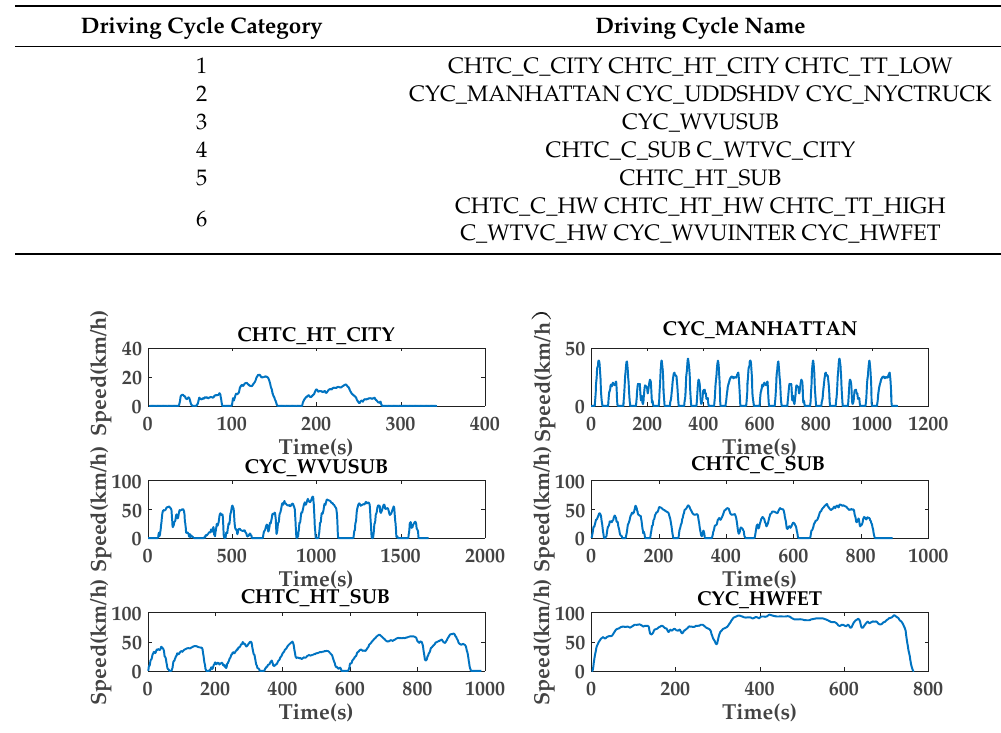
Figure 5. The process of the hierarchical clustering analysis. Table 4. Six types for sample data of driving cycles.